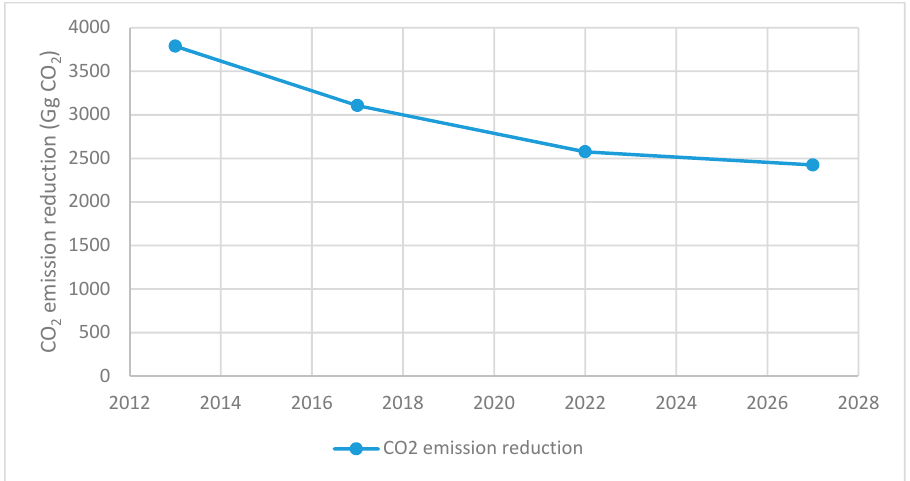
Figure 6. CO 2 reduction to achieve the RE targets.